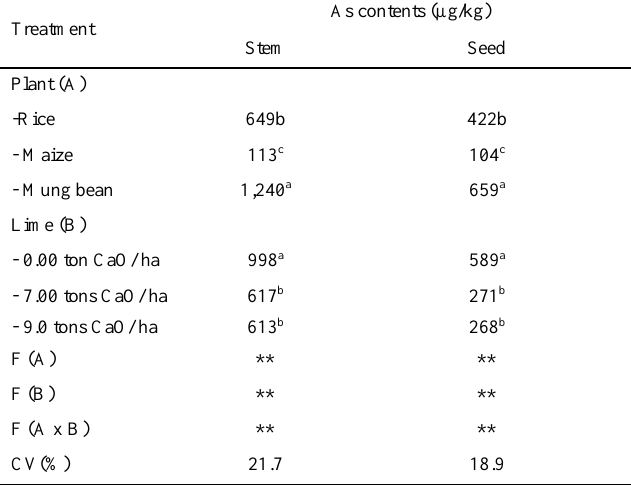
Table 6. Effects of lime ratios on As contents of rice, maize and mung bean